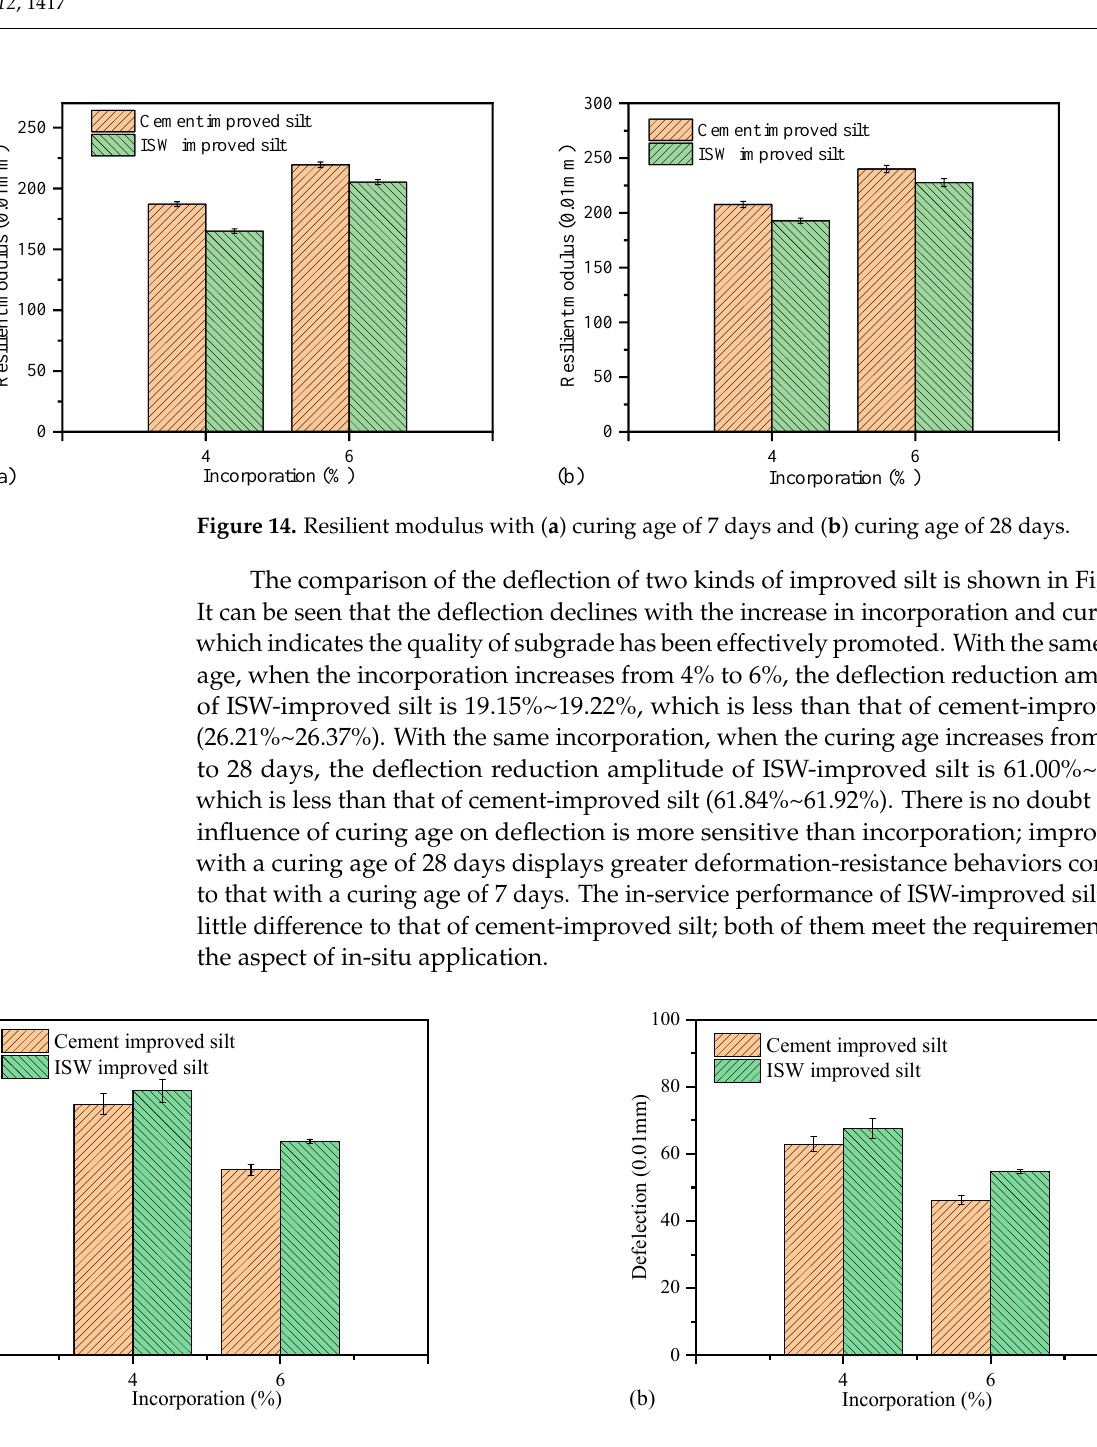
Figure 15. Deflection with ( a ) curing age of 7 days and ( b ) curing age of 28 days.